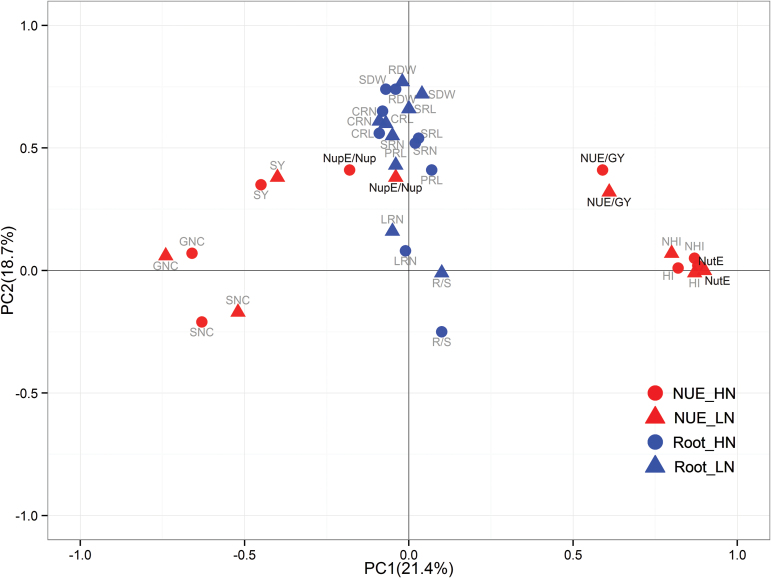
PCA of the RIL population for NUE-related traits (in red) evaluated in the field and for RSA-related traits (in blue) evaluated in hydroponics under the conditions of HN (circle) and LN (triangle) levels. Thirty-six traits were projected onto the first and second principal components.